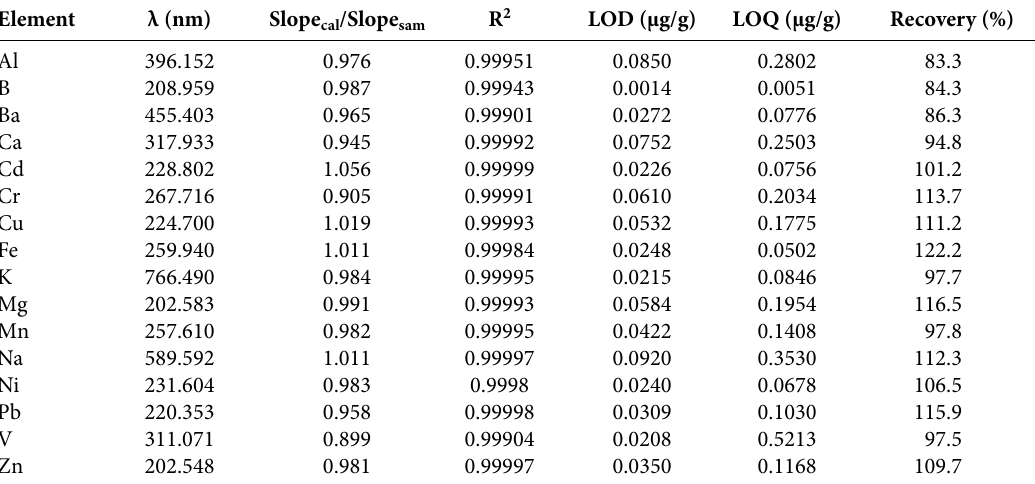
Table 2. Analyte line selected with the ratio Slope cal /Slope sam , regression coefficient (R 2 ), LOD, LOQ of the calibration for each metal determination, and Recovery values for spiked samples. Plasma view mode: axial.